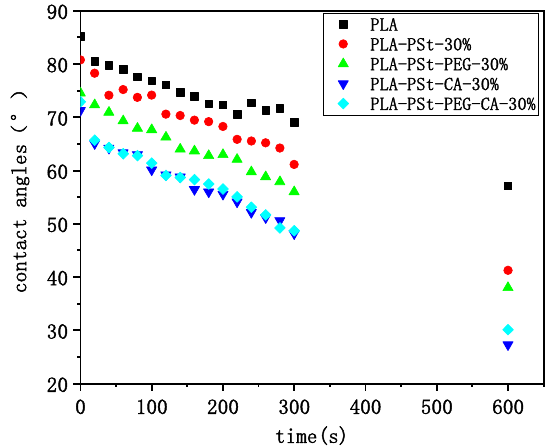
Figure 8. Dynamic contact angles of water in the first 10 min on the surface of pure PLA and PLA / PSt, PLA / PSt / PEG, PLA / PSt / CA, and PLA / PSt / PEG / CA blends.